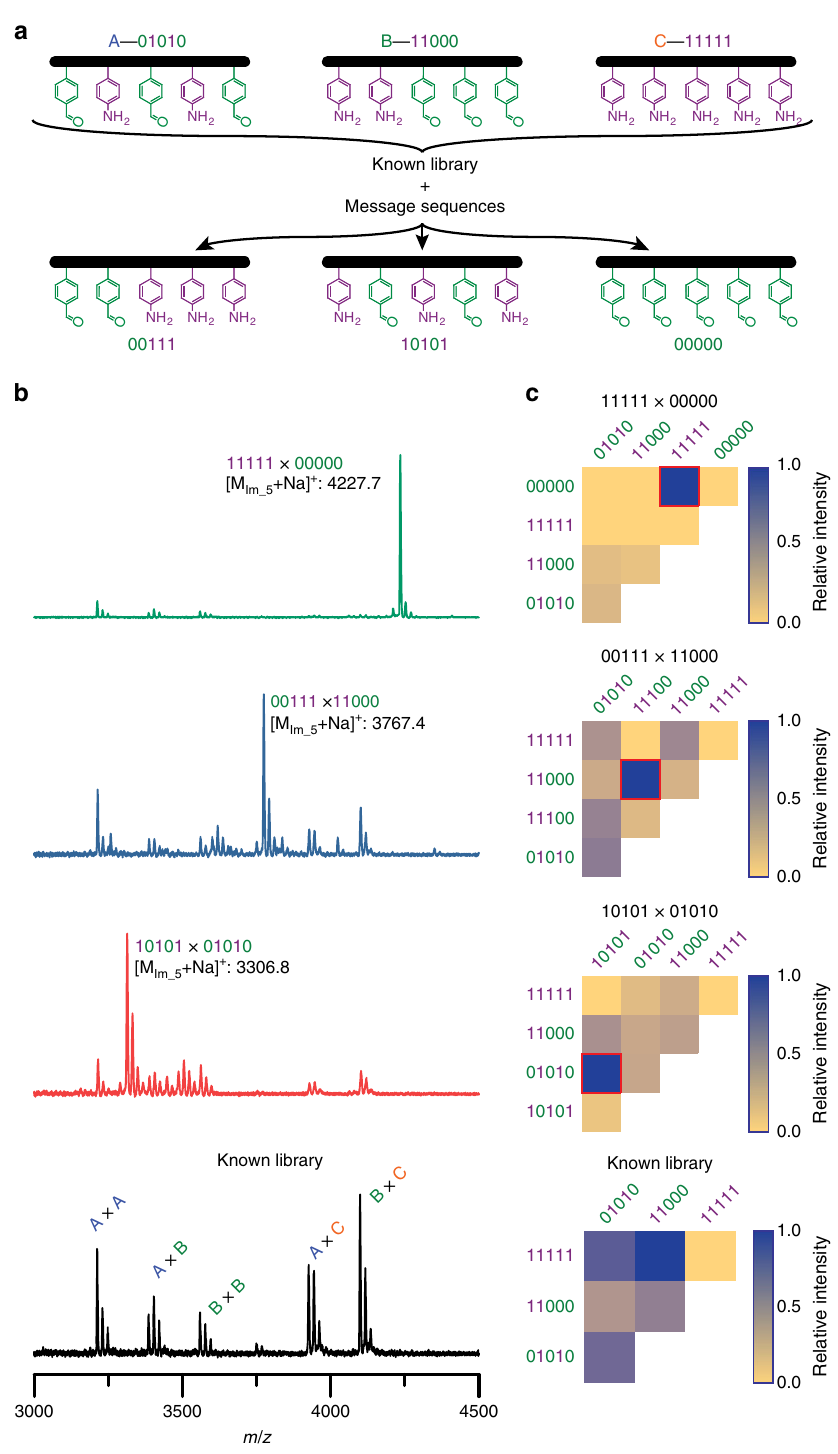
Fig. 4 Dynamic covalent information storage and retrieval. a Schematic of a known library composed of three unique, mass-labeled oligomeric sequences A (01010), B (11000), and C (11111), and individual messages sequences used to challenge the library. b MALDI mass spectrum of the known sequence library treated to the dissociation/extraction/annealing assembly process in the absence of a message strand (black, bottom), resulting in non-speci fi c binding among the library strands, yielding all fi ve possible sets of dimeric ladder species with varying numbers of rungs. Introduction of a message sequence to the known library and treatment of the mixture to the multi-step assembly process yielded MALDI mass spectra with dominant peaks attributable to the in-registry hybridization product of the message strand with its library complement (10101 message, second from bottom, red; 00111 message, second from top, blue; 00000 message, top, green). c Hybridization speci fi city of message strands with their library complements assessed by normalized MALDI mass spectrum intensities. Possible dimeric ladder species are shown; red boxes indicate expected hybrids between message and complementary library strands. Peaks at multiples of + 18 m / z values are attributable to ladders species with fewer